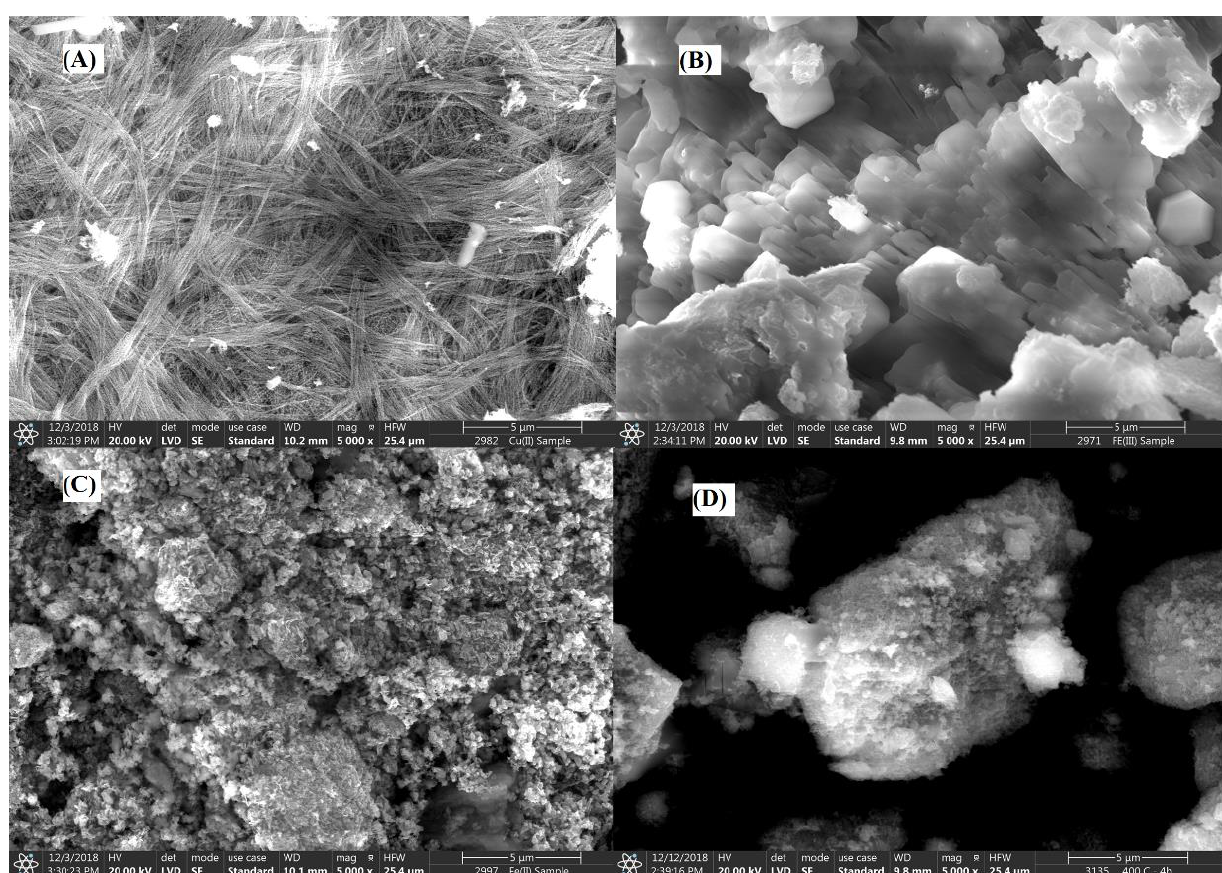
Figure 2. SEM images of synthesized metal oxide and doped ferrite nanoparticles. ( A ) Cu II O, ( B ) Fe III 2 O 3 , ( C ) Fe II O, and ( D ) NP-3.